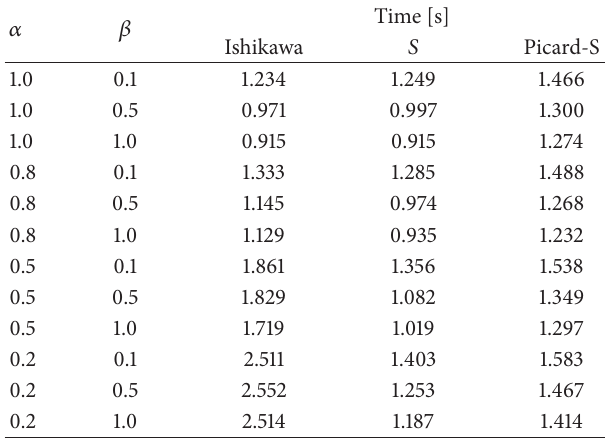
Table 1: Steps’ values and the total numbers of values combinations used in the time tests.